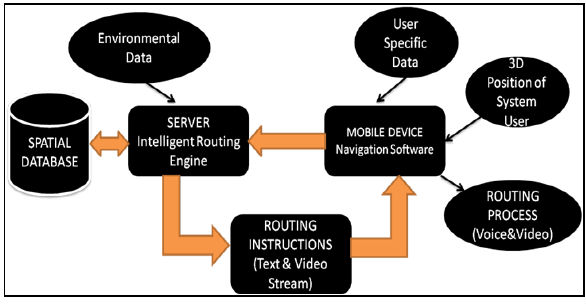
Figure 3. Components of an intelligent indoor evacuation